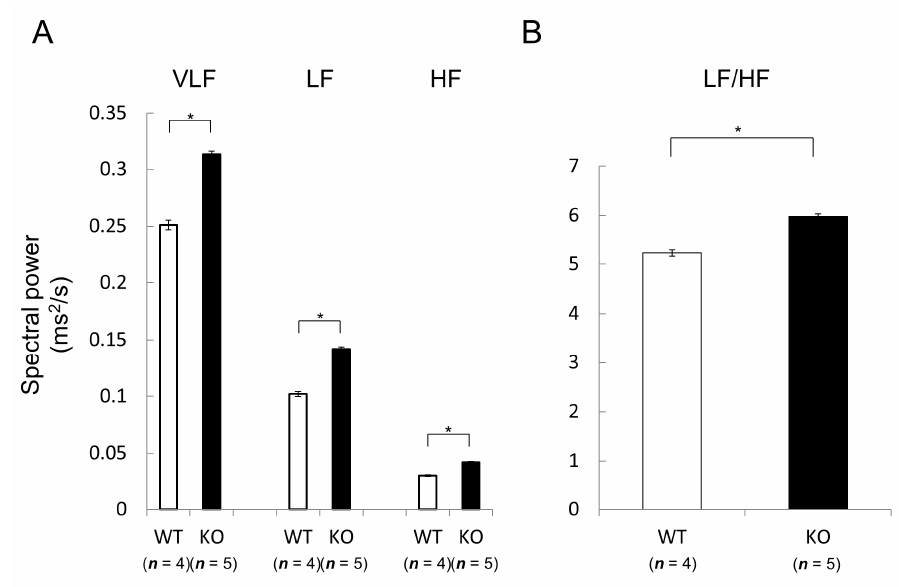
Figure 3. Comparison of basal heart rate variability between wild-type and Nedd4-2 C2-knockout mice assessed by radiotelemetry. Male wild-type littermates ( n = 4; 14–16 weeks old) and Nedd4-2 C2 − / − mice ( n = 5; 14–16 weeks old) were used for this experiment. VLF, LF and HF components of heart rate variability were significantly higher in Nedd4-2 C2 knock out (KO) knockout mice than wild-type mice ( A ). The coefficient between LF and HF spectral power density, which is presumed to reflect sympatho-vagal balance, was significantly increased in Nedd4-2 C2 KO mice ( B ). VLF; Very low frequency, HF; High-frequency, LF; Low frequency. * p < 0.0001.